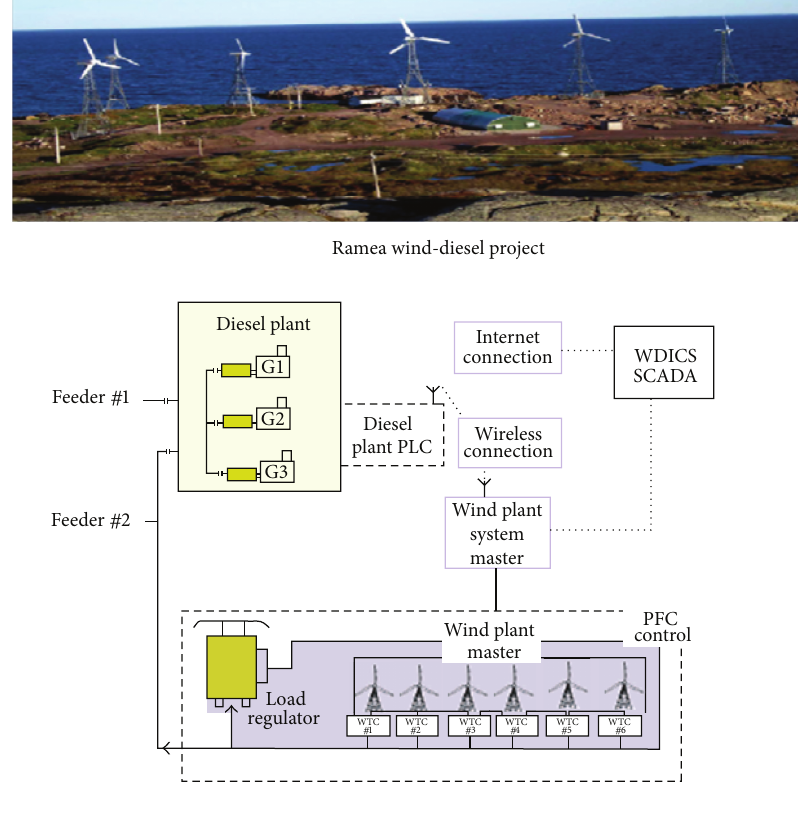
Figure 3: Microgrid system with wind and diesel (without storage) [7].